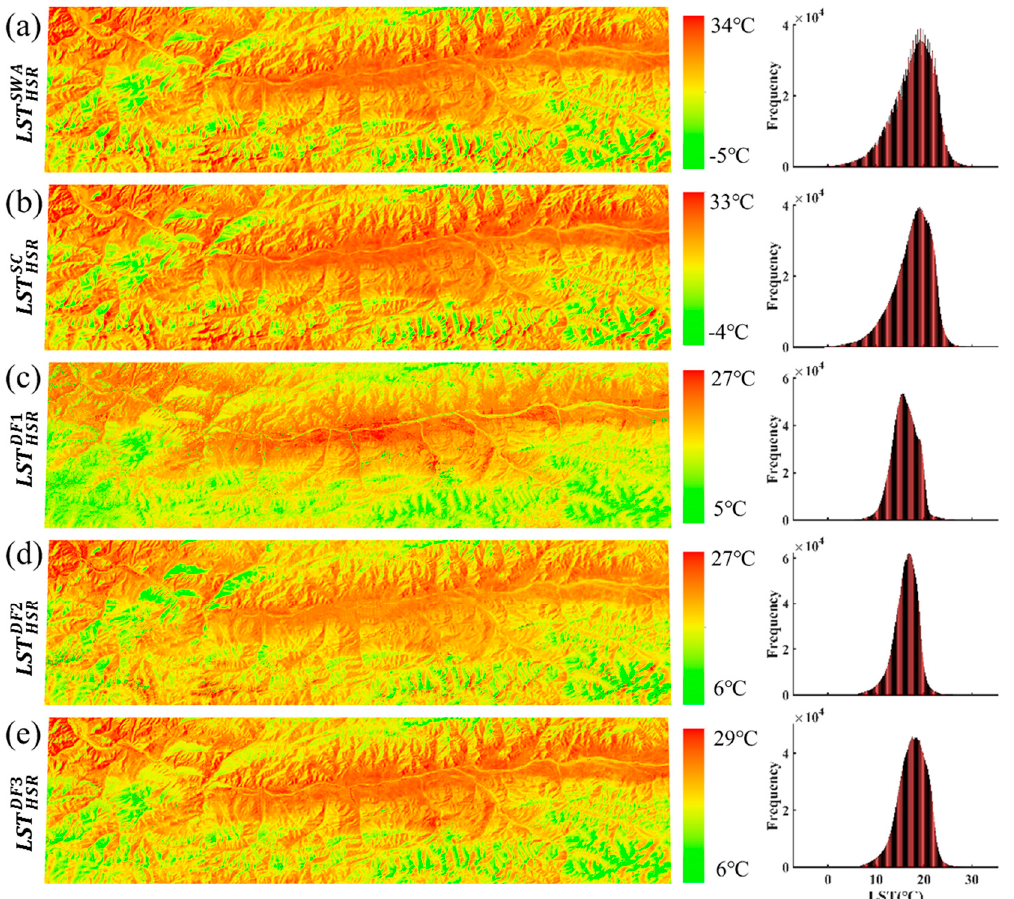
Figure 7. The spatial distribution and frequency histogram of reference LSTs ( a,b ) and the fused LSTs ( c – e ) in Case 1 on 13 September 2015. Table 2. The comparison results of the fused LSTs and MODIS LSTs with reference LSTs in Case 1. LST